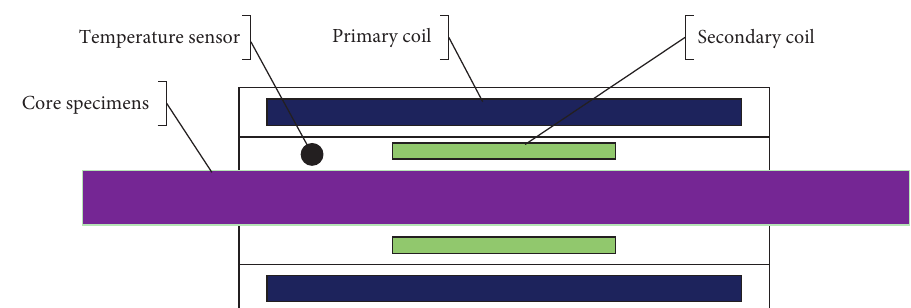
Figure 4: Structural sketch of electromagnetic (EM) sensor.